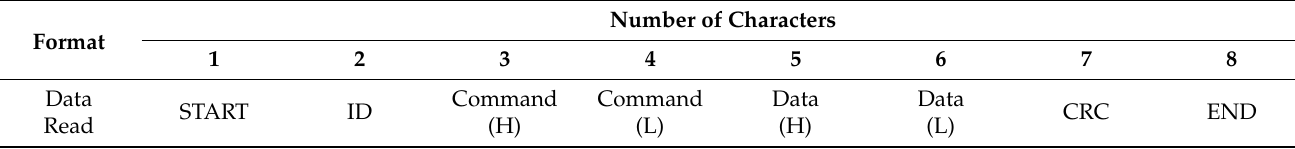
Table 1. The protocol of the master command message.